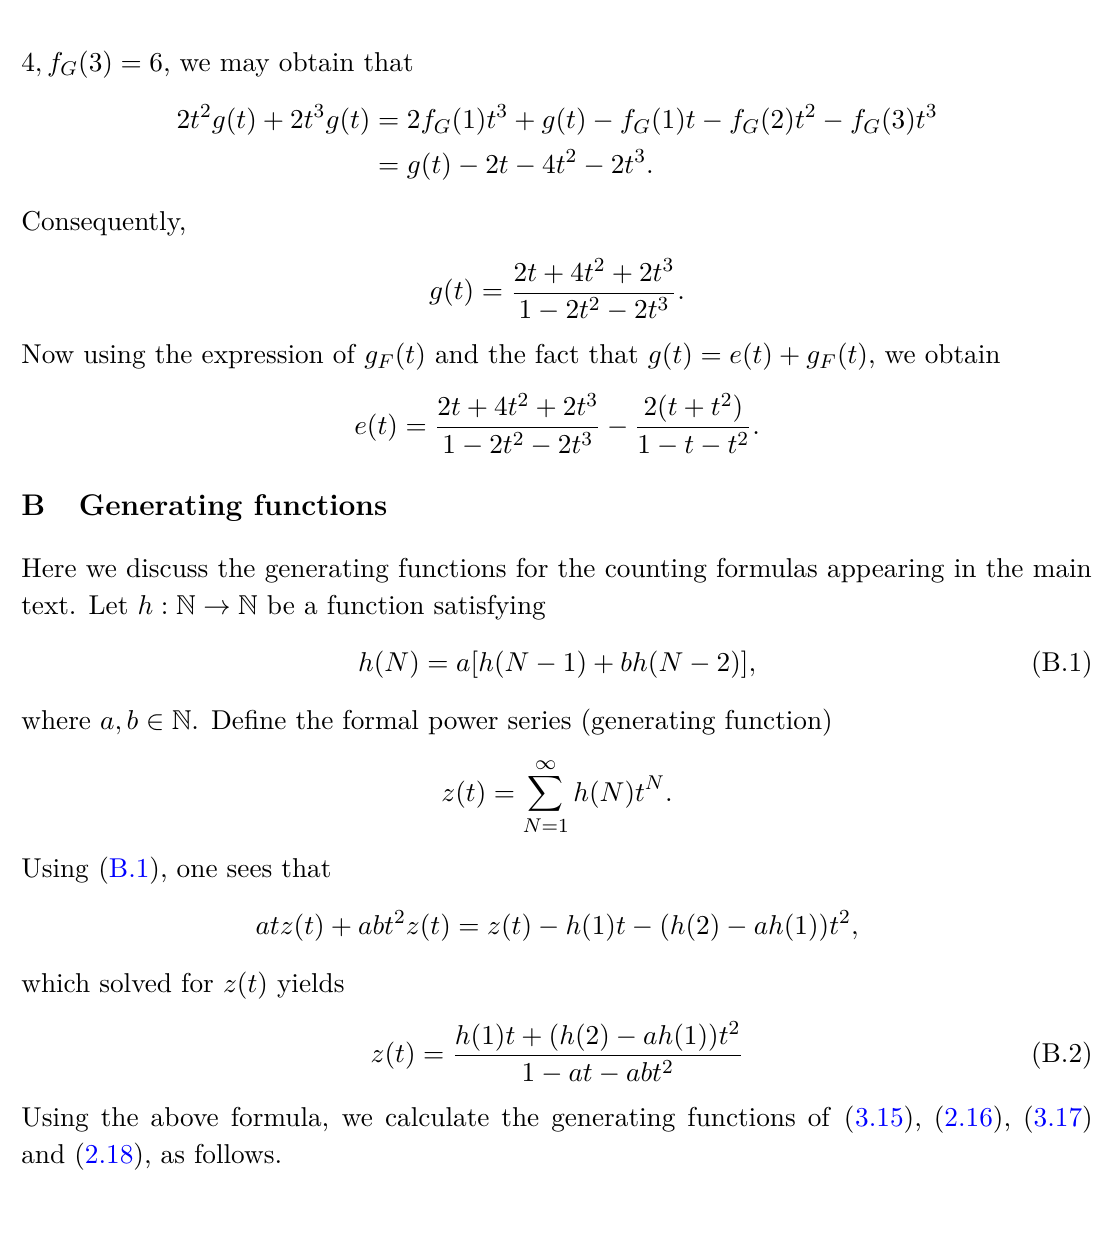
Table 11 . Counting of all the ground states. This table coincides with table II of